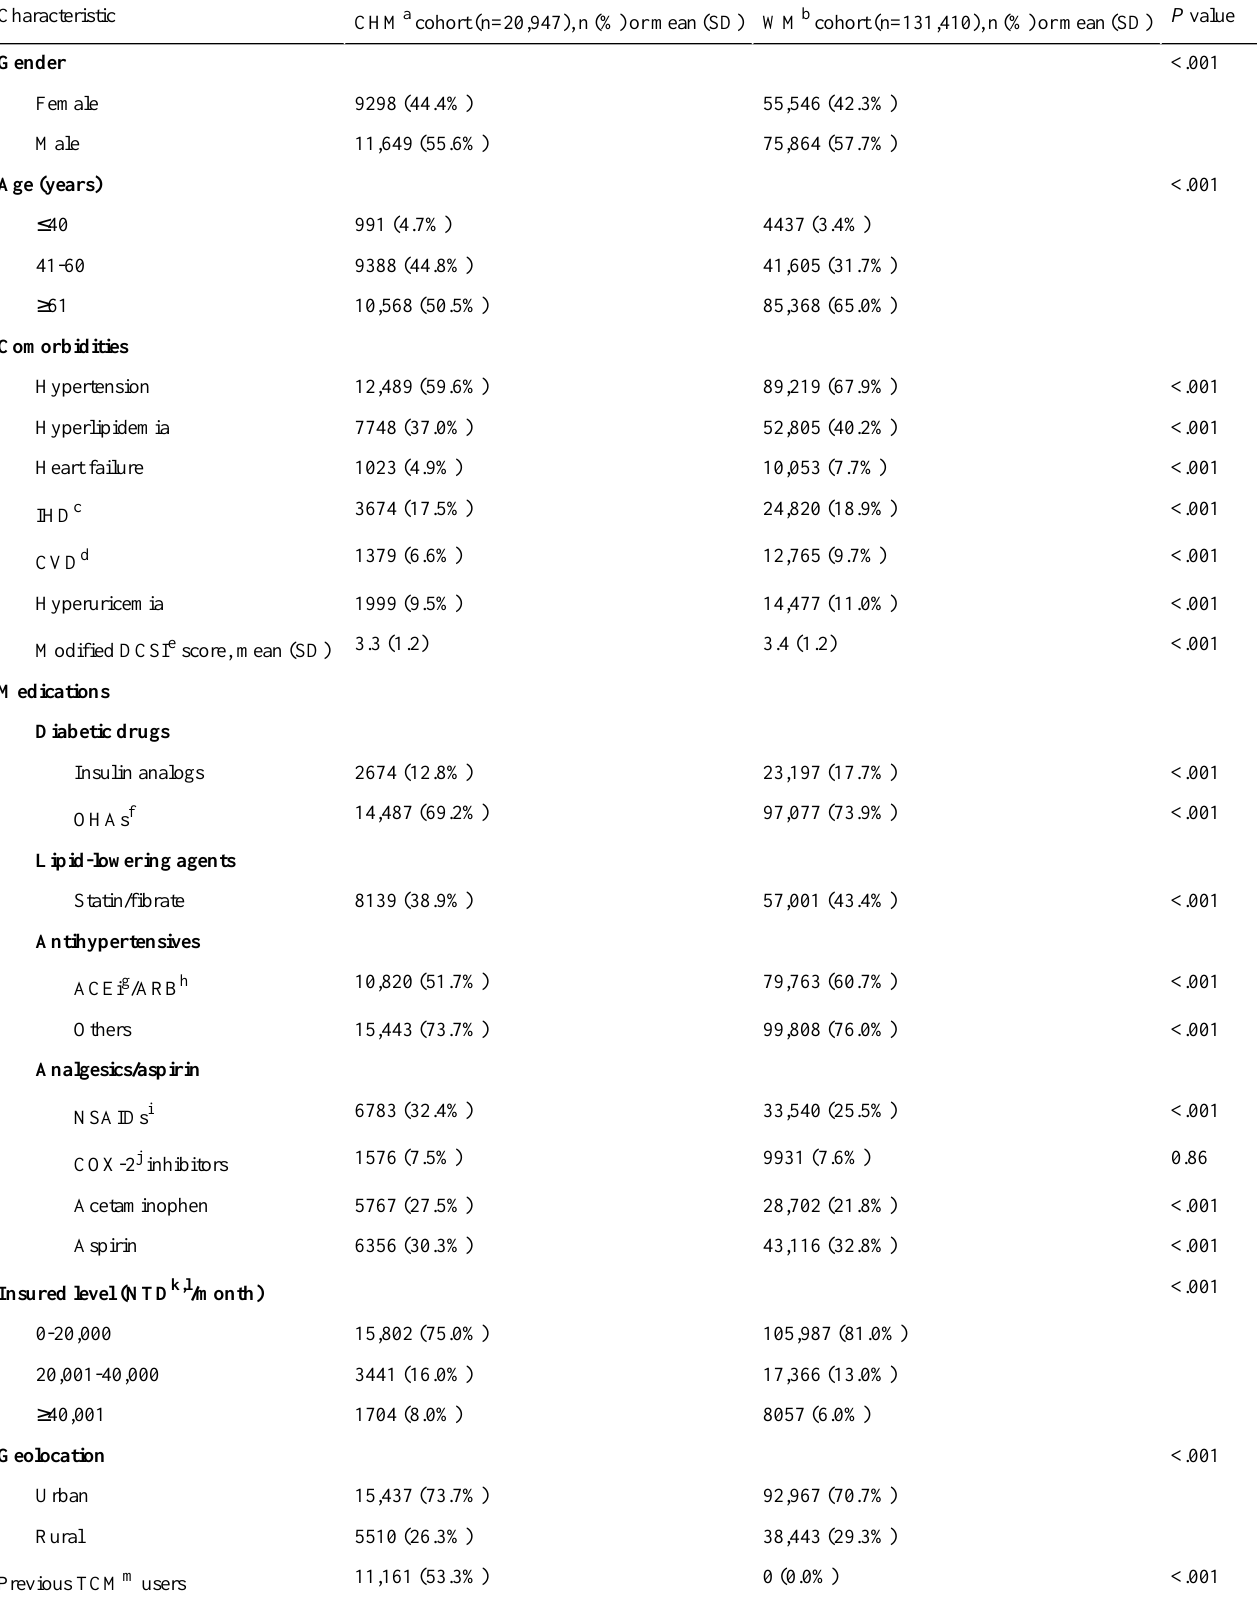
Table 1. Characteristics of the Chinese herbal medicine and Western medicine cohorts among incident diabetic kidney disease patients from 2004 to